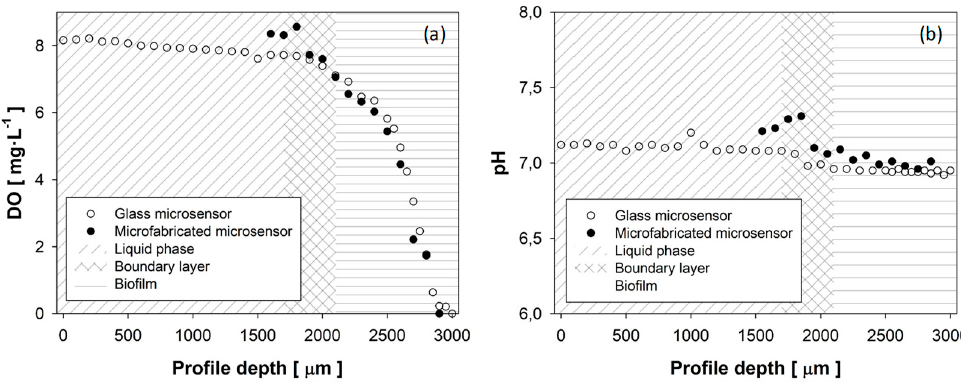
Figure 4. DO ( a ) and pH ( b ) profiles recorded with commercial microsensors and the microfabricated